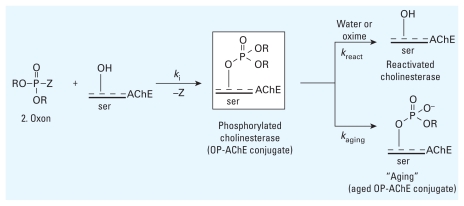
Formation of OP oxon and reactions with AChE. Abbreviations: kaging, aging (nonreactivation) rate constant; ki, inhibition rate constant; kreact, reactivation rate constant.